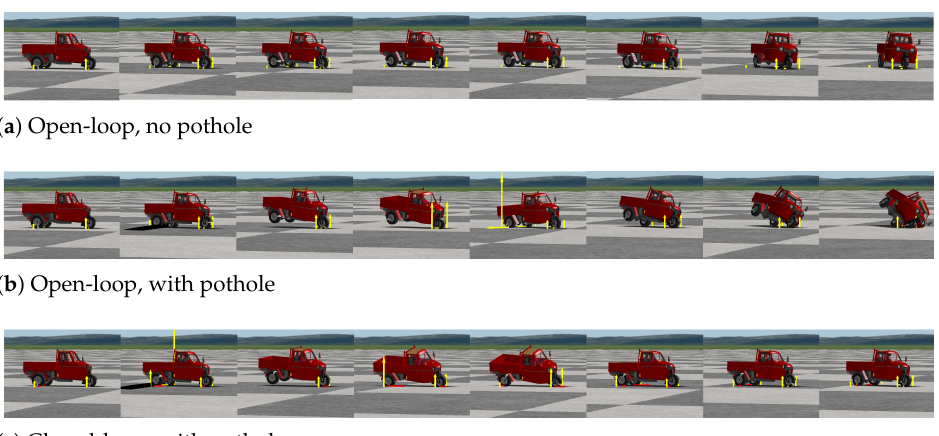
Figure 14. Comparative of TWV animations in open (up and middle) and closed-loop (bottom) with µ = 0.6, l f = 0.882 m, l r = 1.143 m, h = 0.432 m, b r = 0.625 m, bl = 0.425 m and m = 597 kg, for the maneuver of Figure 2a augmented by 300%. The pothole is simulated for the last two simulations by the exogenous road step of Figure 2b multiplied by − 1 and shifted to begin at second 5.6, only in the rear left wheel. Snapshots are taken at the same distance from the beginning of the maneuver. The DSC can recover the driveability of the TWV and avoid the rollover. In the Supplementary Material Section, a link is provided to the full